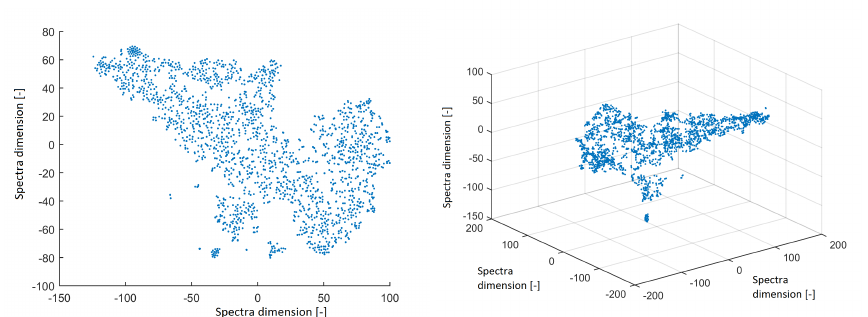
Figure 2. Reduced space of spectra to 2D from independent components (ICs) after using the t-distributed stochastic neighbor embedding (t-SNE) method with a perplexity of 30 ( left ). Reduced space of spectra to 3D from ICs after using the t-SNE method with a perplexity of 30 ( right ).